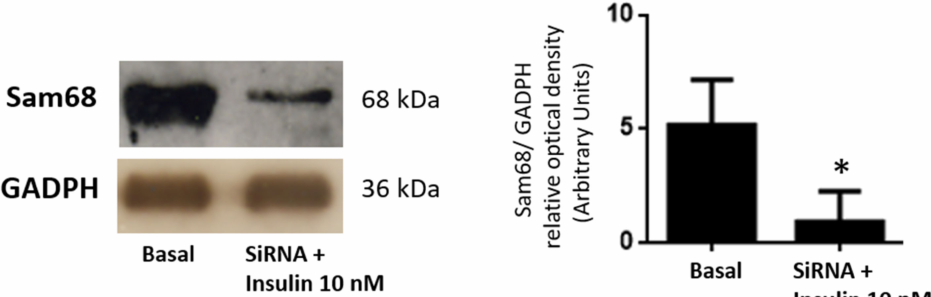
Figure 2. Control of inhibition of Sam68 by using siRNA in human GCs from healthy donors. GCs were transfected with Sam68 siRNA or NC1-scrambled negative control siRNA (basal) duplexes, as described in Section 2, and incubated in absence or presence of 10 nM insulin for 10 min. GCs lysates were separated by SDS-PAGE and Western blot analysis was performed by using anti-Sam68 antibodies to study sam68 expression. Sample protein loading was controlled by using anti-GAPDH antibodies. We show the corresponding densitometric analysis of three independent experiments as means ± SD; statistical analyses were performed by ANOVA. Asterisks indicate significant differences from the un-treated controls according to Bonferroni’s multiple comparison post-hoc